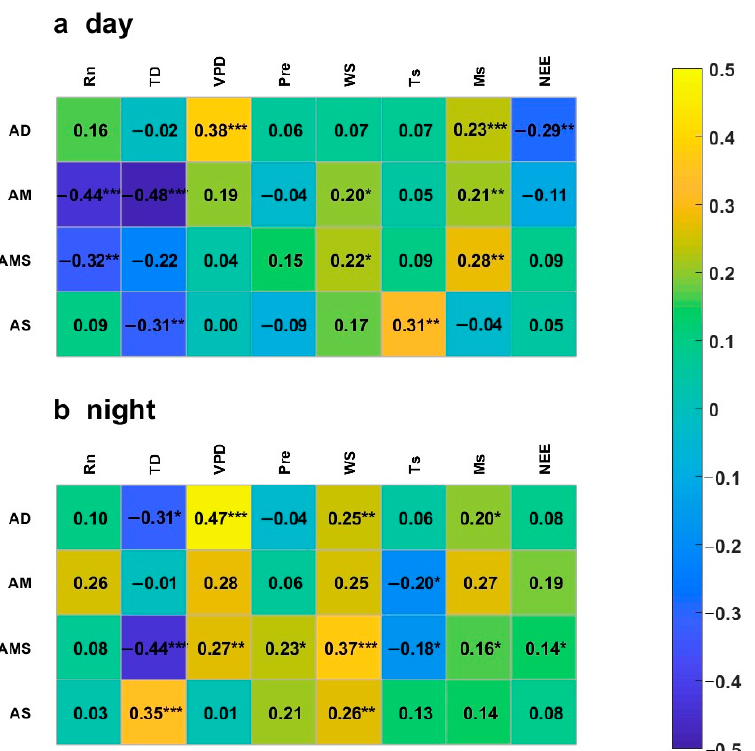
Figure 5. The sensitivity coefficient between daytime ( a ) and nighttime ( b ) climate factors and evapotranspiration at alpine desert (AD), alpine meadow (AM), alpine meadow steppe (AMS), and alpine steppe (AS) in the Qinghai Lake Basin. Rn , TD , VPD , Pre , WS , Ts , Ms , and NEE are the net radiation, temperature difference ( Ta − LST ), vapor pressure difference, precipitation, wind speed, soil temperature, soil moisture, and net ecosystem exchange. *, **, and *** represent statistical significance at the p < 0.05, p < 0.01, and p < 0.001 levels, respectively.